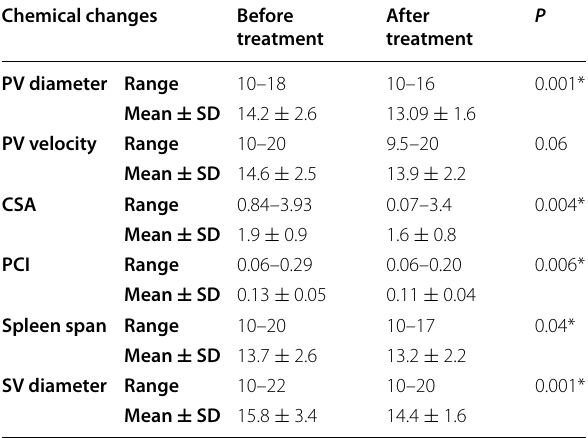
PV portal vein, SV splenic vein, CSA cross-sectional area, PCI portal congestion index